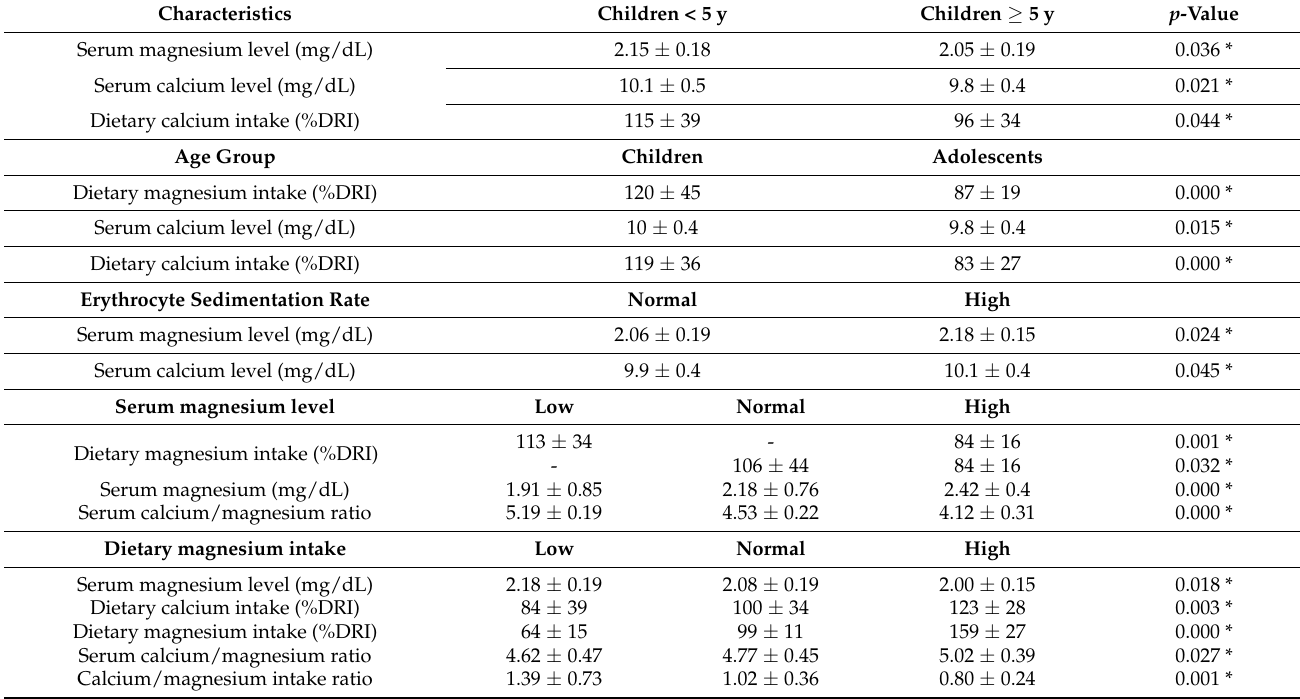
Table 5. Differences between participants with chronic diseases ( n =